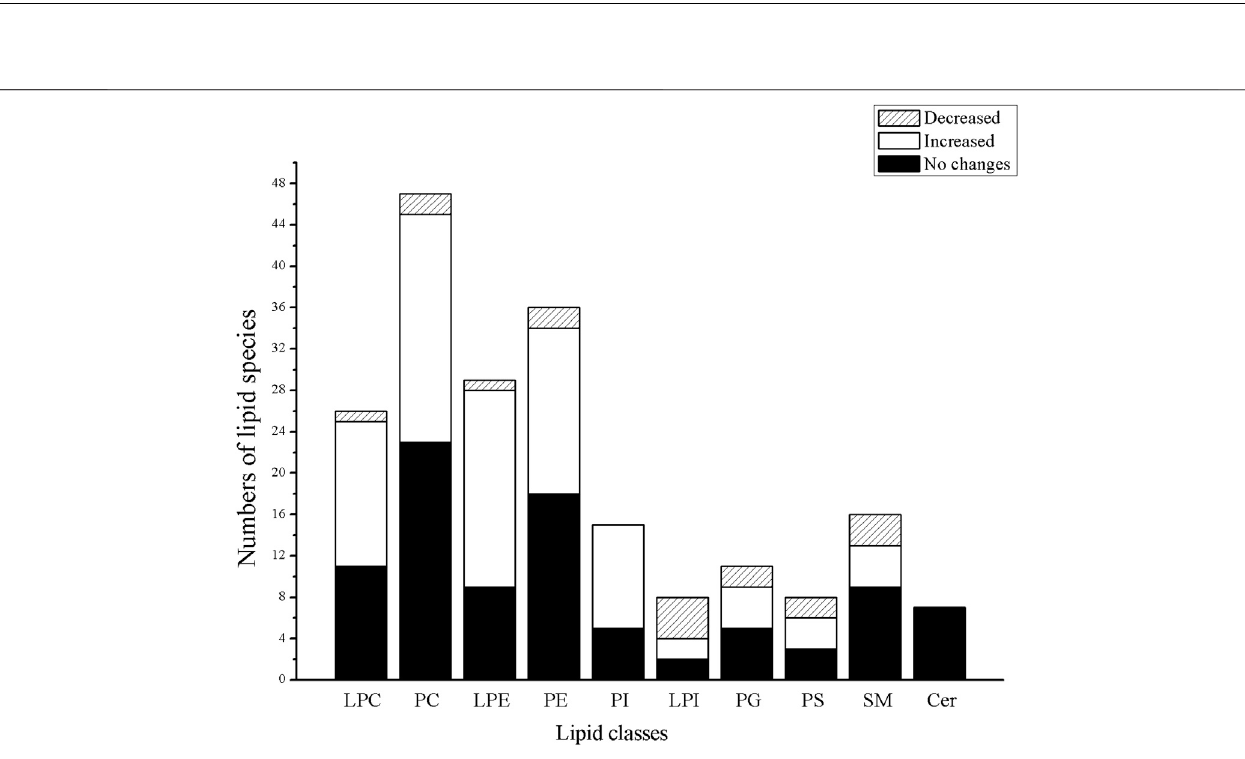
( Figure 6II ). It demonstrated that the alterations of metabolic pattern of given lipids was obviously induced by co-treated HSW with LPS.